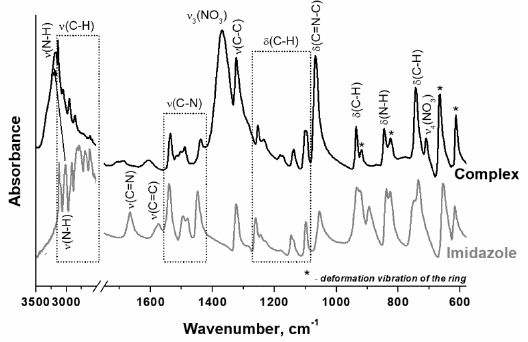
Figure 2. ATR FTIR spectra of the prepared hexakis-(imidazole) nickel (II) nitrate complex and imidazole. Additional evidence for the formation of hexakis-(imidazole) nickel (II) nitrate complex is provided by thermal analysis (Figure 3) and XRD (Figure S2) data. Thus, the DTA curves show no endothermic peaks at 90 and 265 °C, which corresponds to the melting and boiling of imidazole, respectively. Moreover, there is no mass loss and thermal effects due to the decomposition of nickel nitrate hexahydrate [54]: Ni(NO 3 ) 2 ·6H 2 O → Ni(NO 3 ) 2 ·4H 2 O + 2H 2 O (10) Figure 3. Thermal decomposition of the synthesized hexakis-(imidazole) nickel (II) nitrate complex (helium, 5 °C·min − 1 ). According to thermal analysis (Figure 3), a noticeable decomposition of the complex begins at temperatures above 150 °C with an endothermic effect, but the main weight loss above 230 °C takes place with the release of a large amount of heat. The saw-like form of